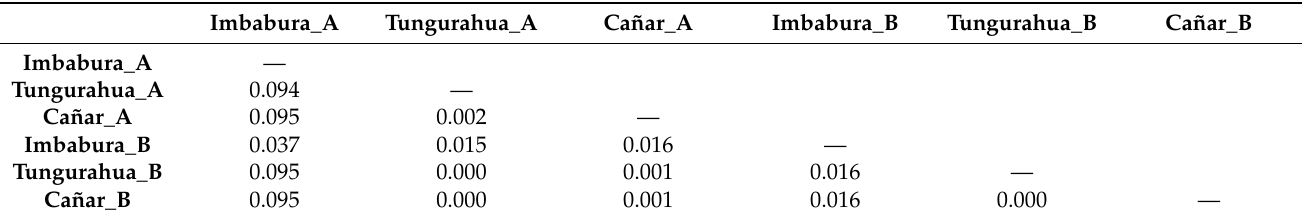
Table 5. Matrix of Nei’s genetic distances among the six groups of accessions analyzed (two collec- tions, A and B, x three provinces: Imbabura, Tungurahua, and